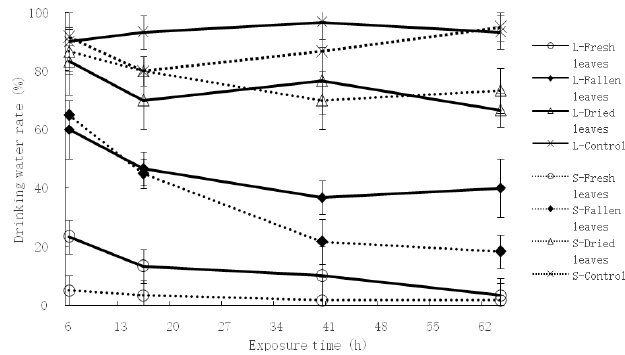
Fig 3 . Effects on drinking ability of workers (L: large workers, S: Small workers) after treated with different mashed leaves of M. alba ( Duncan′S Multiple-Range test, SPSS17.0).